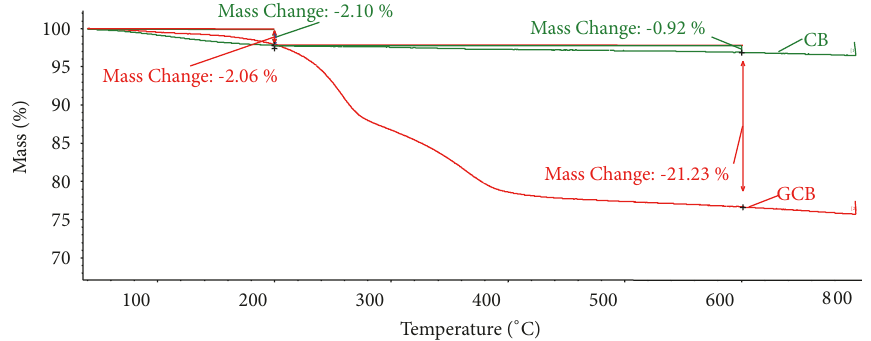
Figure 1: TGA analysis of carbon black before and after